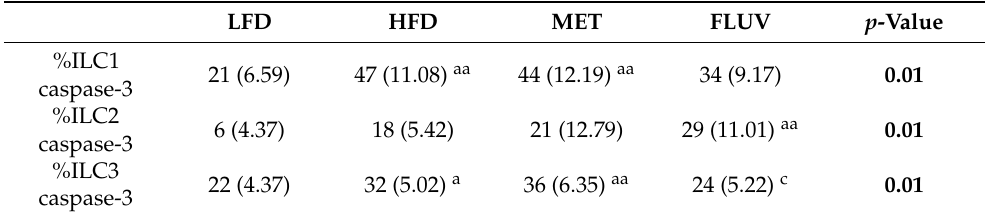
Table 2. Caspase-3 expression on innate lymphoid cell subtypes after treatments with metformin and fluvastatin.